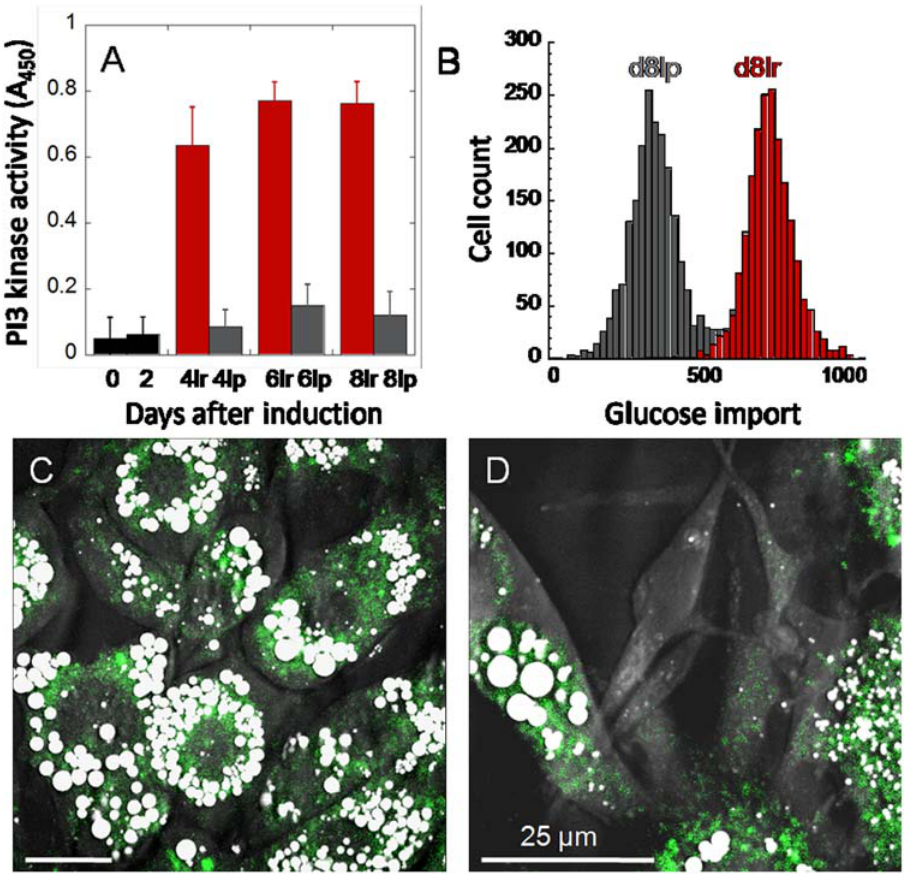
Figure 6. Increased kinase activity and glucose import in lipid-rich cells. ( A ) PI3K kinase activity of undifferentiated cells is significantly lower than differentiated cells. 8lr and 8lp represent sorted lipid-rich and lipid-poor cell populations at day 8 after adipogenesis induction, respectively. Error bars represent distribution across 4 repeated experiments. ( B ) Flow cytometry analysis of the import of a fluorescent glucose analog in a population of cells at day 8. Lipid-rich cells (red) exhibit approximately 2-fold higher in fluorescent glucose intensity than lipid-poor cells (grey). Imaging reveals strong glucose import in lipid-rich cells ( C ) as compared to lipid-poor cells ( D ). ( C, D ) Cells at day 6 are used for imaging. Scale bars: 25 m